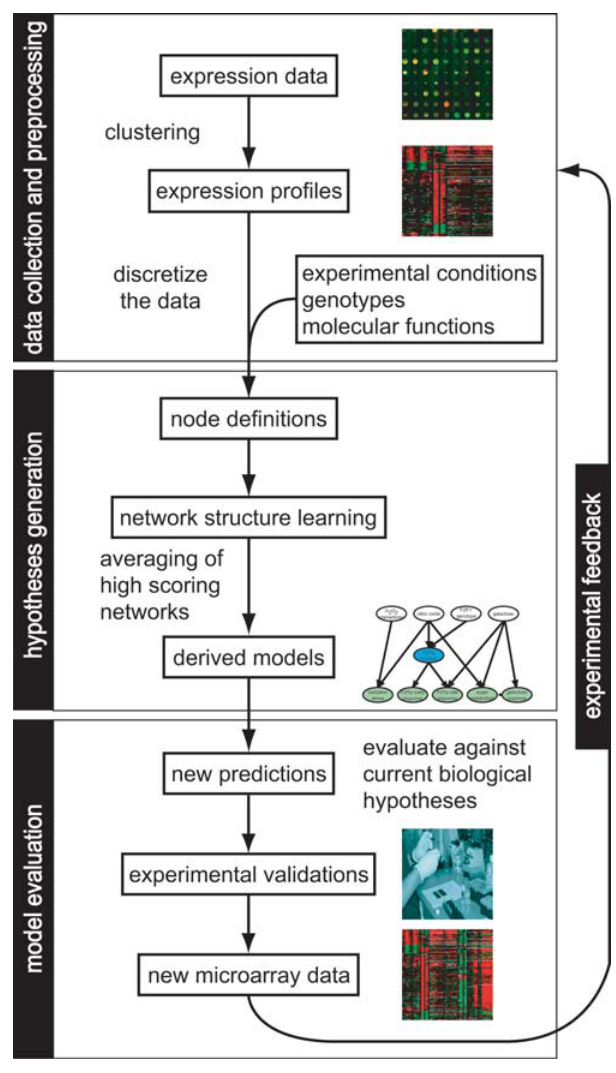
Figure 1. Illustration of the iterative network learning and experimental feedback